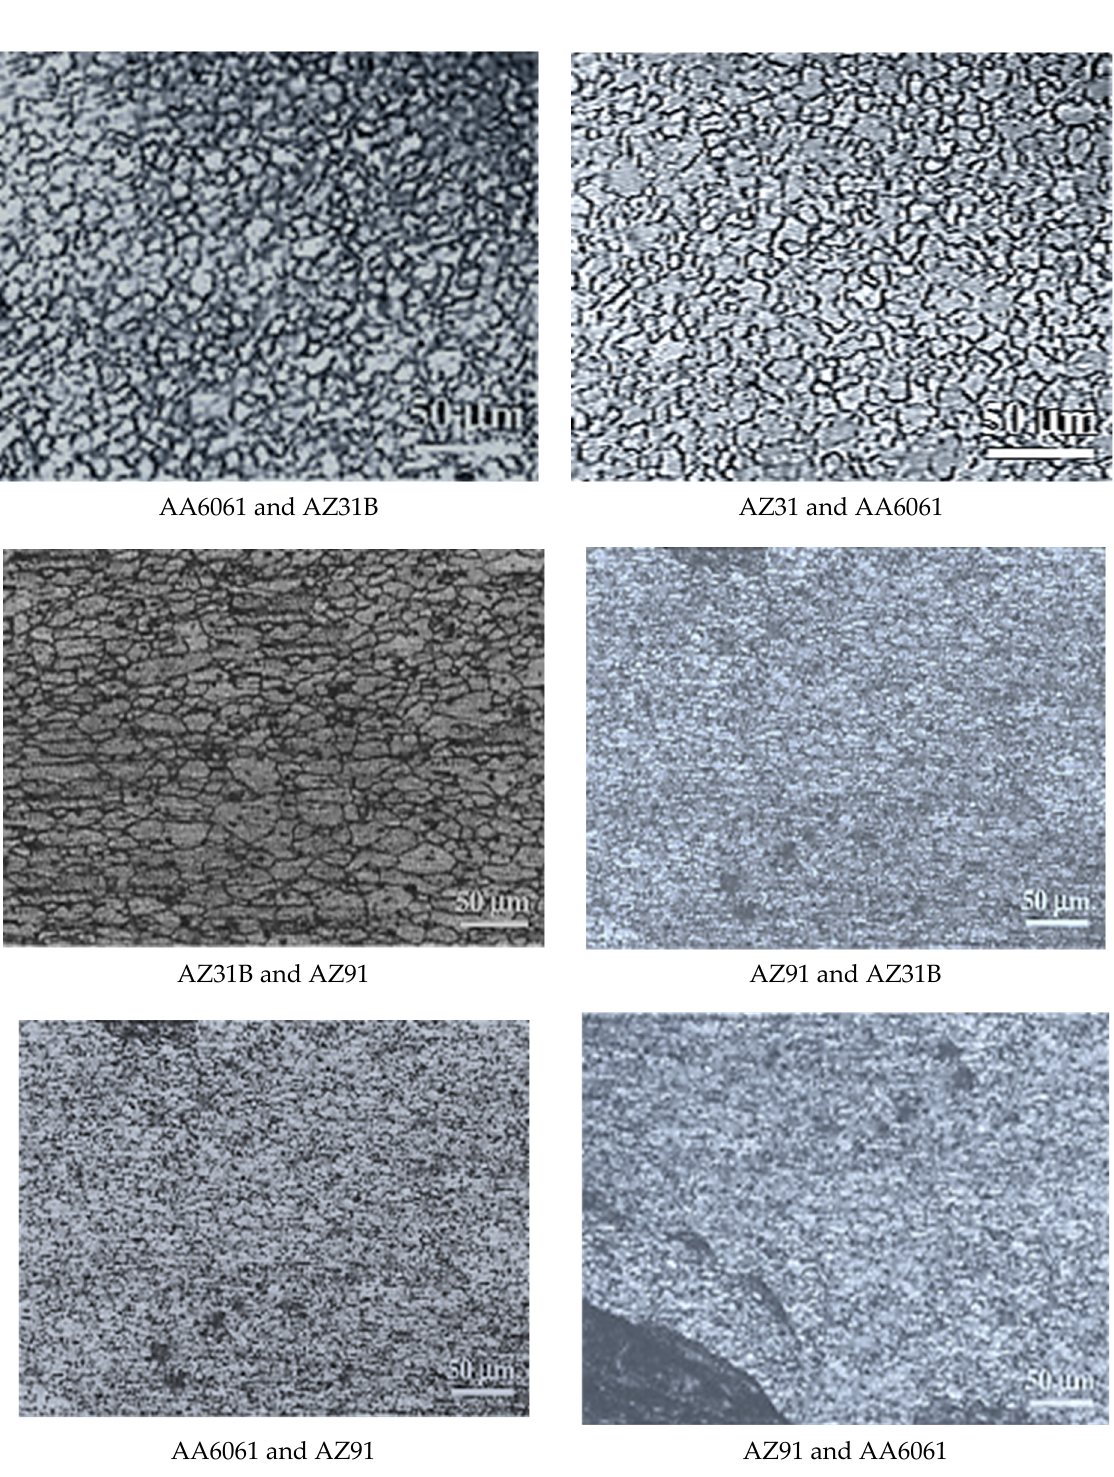
Figure 7. Micrographs of AA6061 and AZ31B, AZ31 and AA6061, AZ31B and AZ91, AZ91 and AZ31B, AA6061 and AZ91, and AZ91 and AA6061 joints in the SZ region.